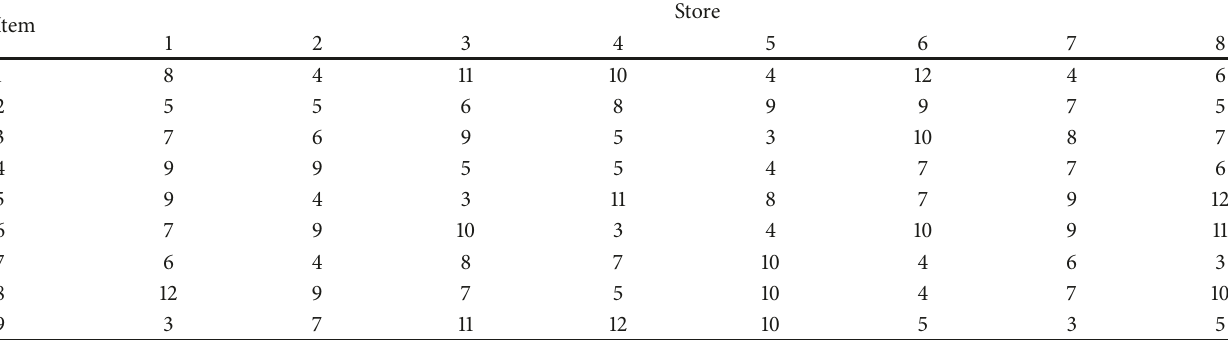
Table 3: Demand on different items for different